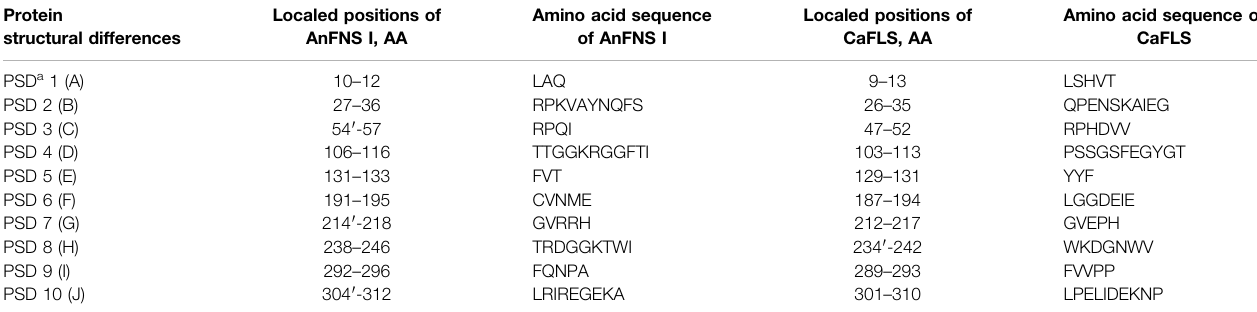
TABLE 4 | Protein structural differences between AnFNS I and CaFLS. Protein structural differences